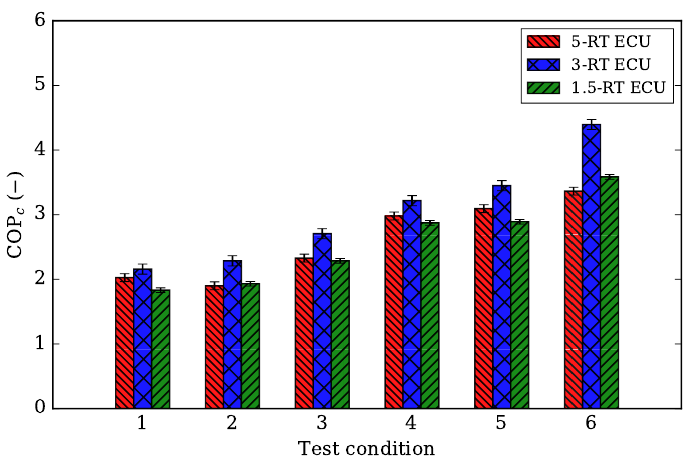
Figure 5. Comparison of cycle coefficient of performance for 1.5-RT, 3-RT, and 5-RT ECUs.